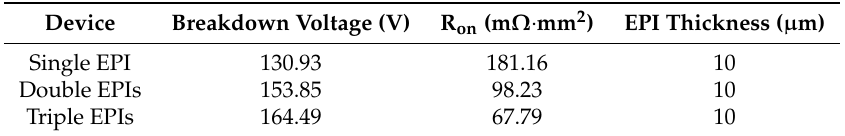
Figure 7. The simulated electric field curves for all devices with single EPI, double EPIs, and triple EPIs with the same total EPI thickness. Table 3. The characteristics of single-EPI, double-EPIs, and triple-EPIs SGT power MOSFET with the same total EPI